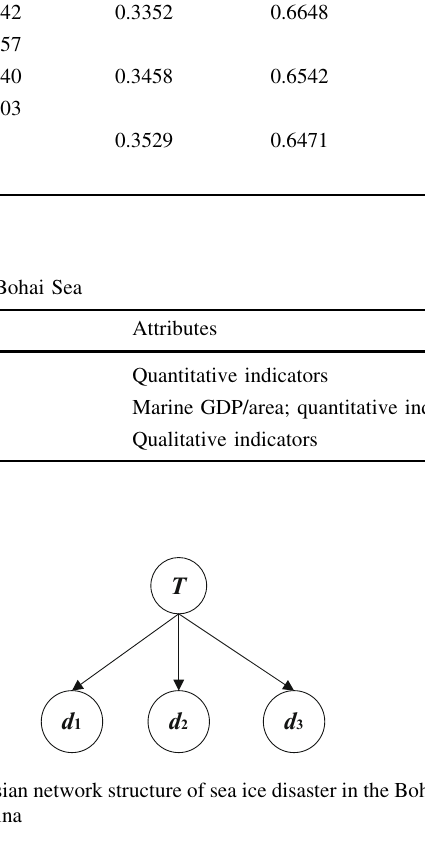
Table 3 Comparison of the conditional probability table calculation with different algorithms Number of iterations, time of